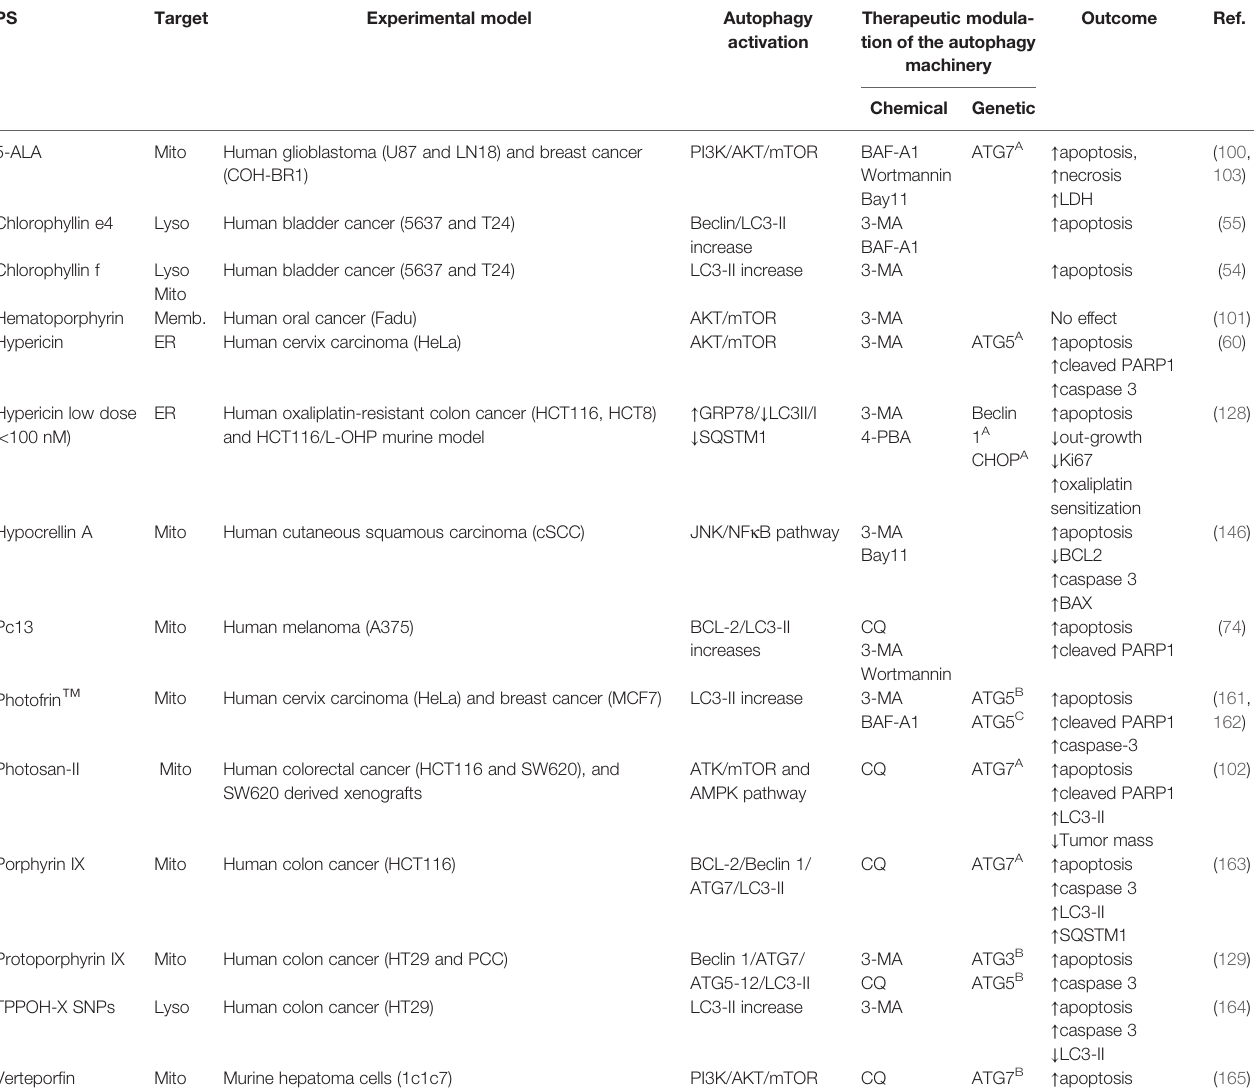
TABLE 1 | PDT-mediated autophagy: cytoprotective role and modulatory guidelines to increase tumor outcome.